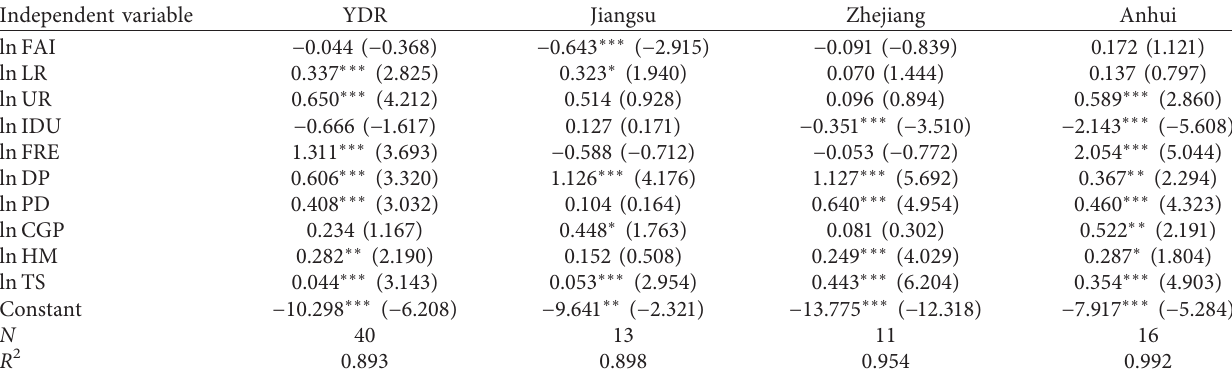
Table 8: Regression results of headquarters-branches enterprise